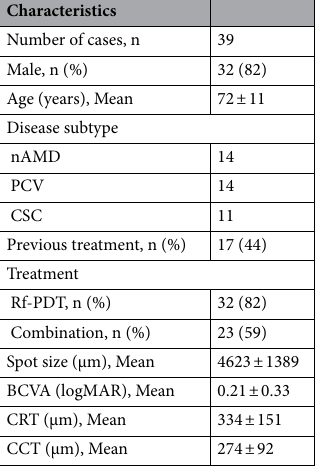
Table 1. Patient characteristics at